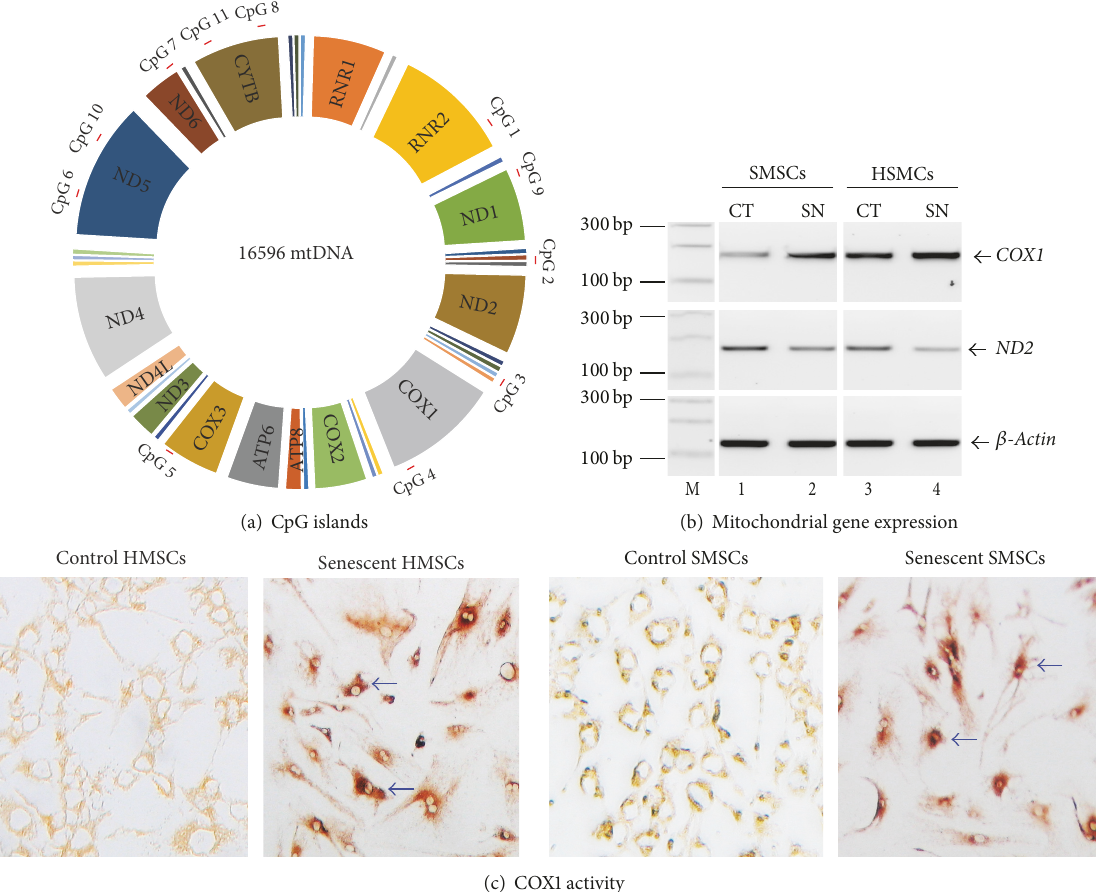
Figure 4: Alteration of mitochondrial genes during cellular senescence. (a) Location of CpG islands in the mitochondrial genome. (b) Altered gene expression of mitochondrial COX1 and ND2 genes in senescent MSCs. (c) The enzyme activity of COX1 in control and senescent